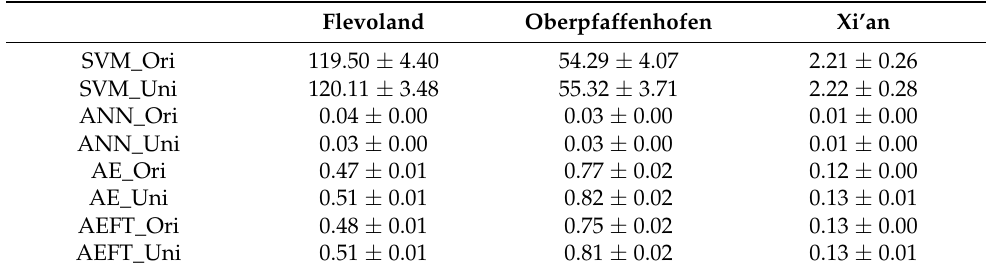
Table 19. Prediction time of four classifier for parameter normalization on three PolSAR